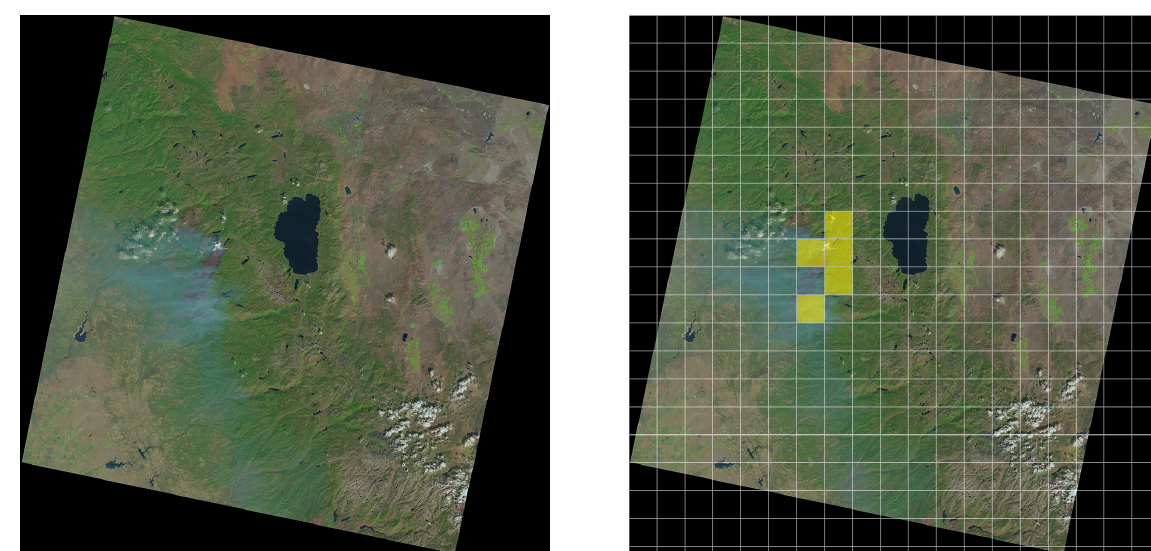
Figure 1. An example of a scene. Left: true color image of scene 1; Right: Scene 1 with 400-by-400 pixels grid. Square images with enough fire pixels inside are filled with yellow color.